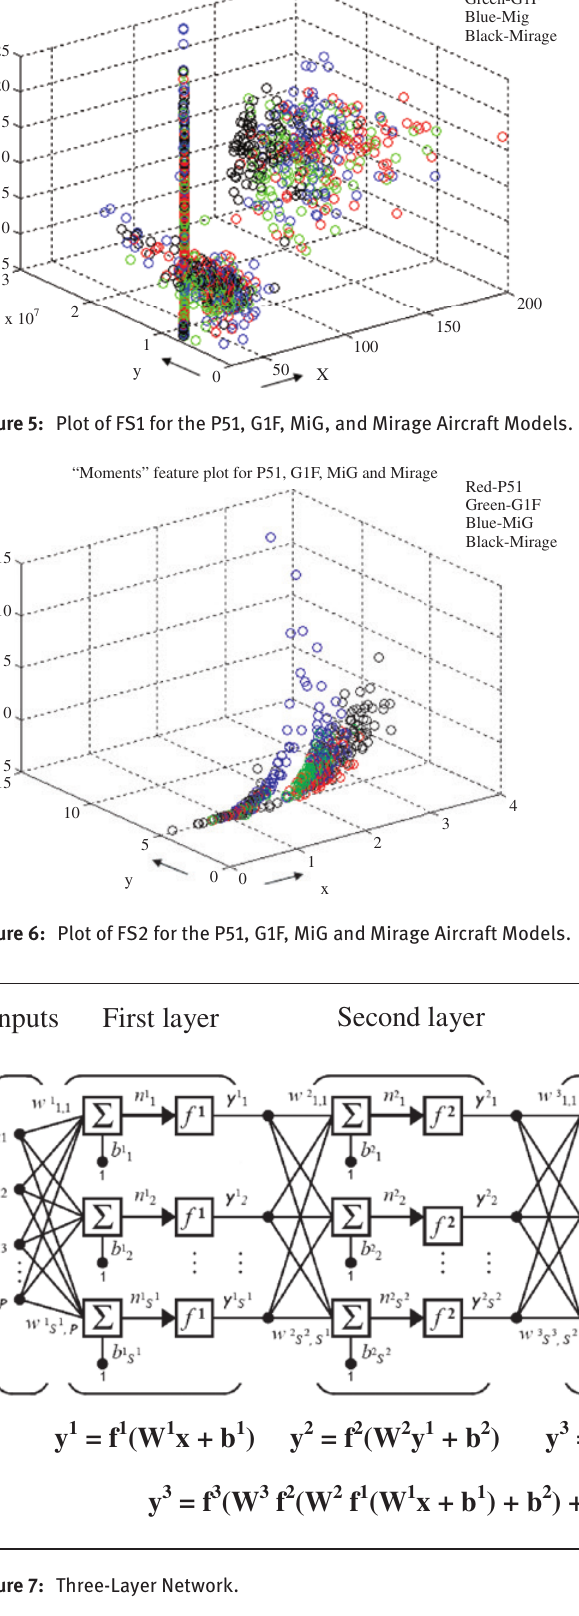
Figure 7: Three-Layer